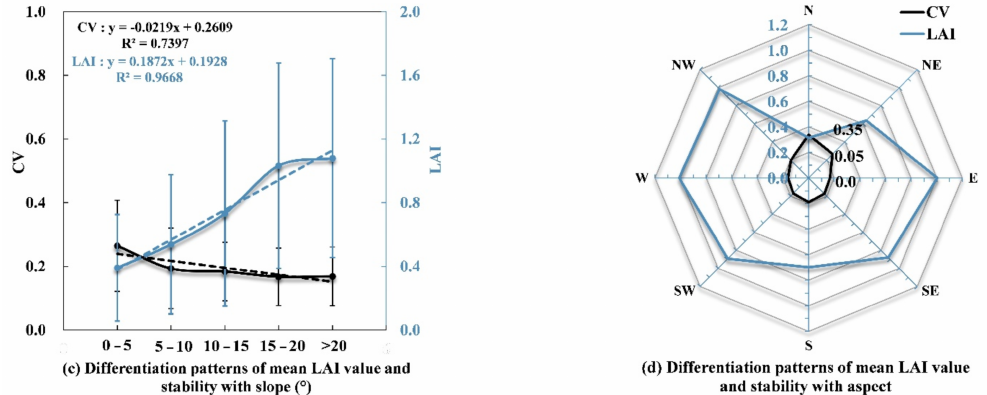
Figure 6. Differentiation patterns of mean LAI value and stability with ( a ) elevation, ( b ) relief amplitude, ( c ) slope, and ( d ) aspect. Vertical lines indicate the standard deviations of CV and mean LAI value in ( a ) elevation, ( b ) relief amplitude, and ( c ) slope. Moreover, the dotted line represents the results of ordinary least squares regression.